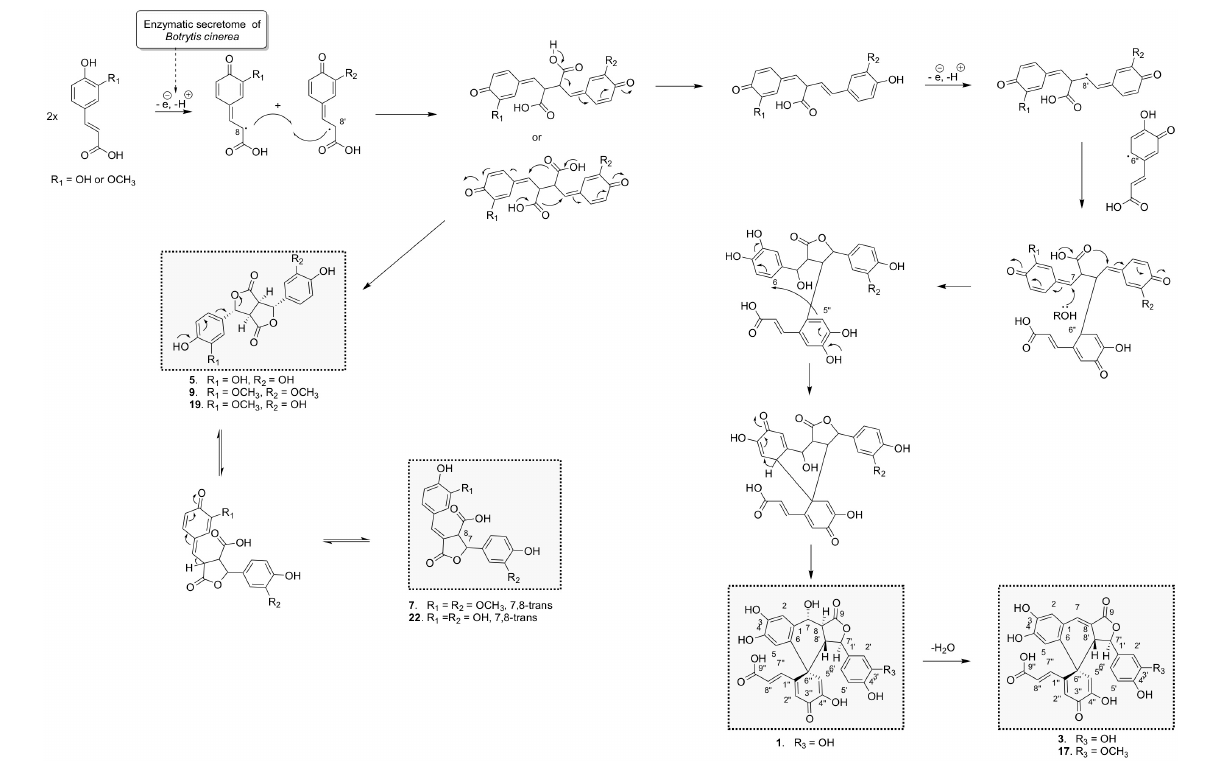
FIGURE 7 | Proposed chemoenzymatic pathway for the formation of compounds 1, 3, 6, 7, 9, 17, 20, and 23 by 8-8 (cid:48) phenoxy radical